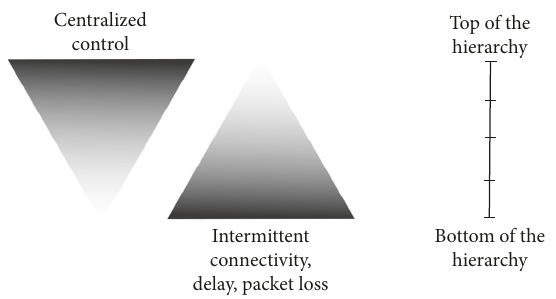
Figure 1: Change in the network quality and management cen- tralization in relation to the hierarchical position in the